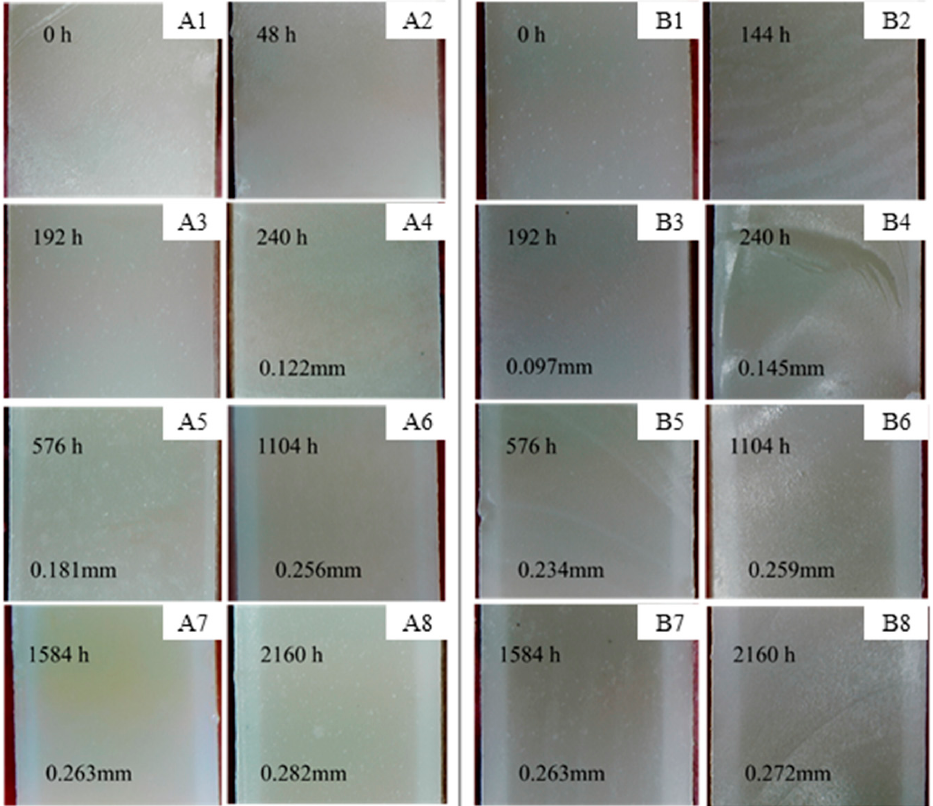
Figure 5. Cross-sectional images of the epoxy resin casting sheets after different ageing Figure 5. Cross ‐ sectional images of the epoxy resin casting sheets after different ageing time (( A1 –